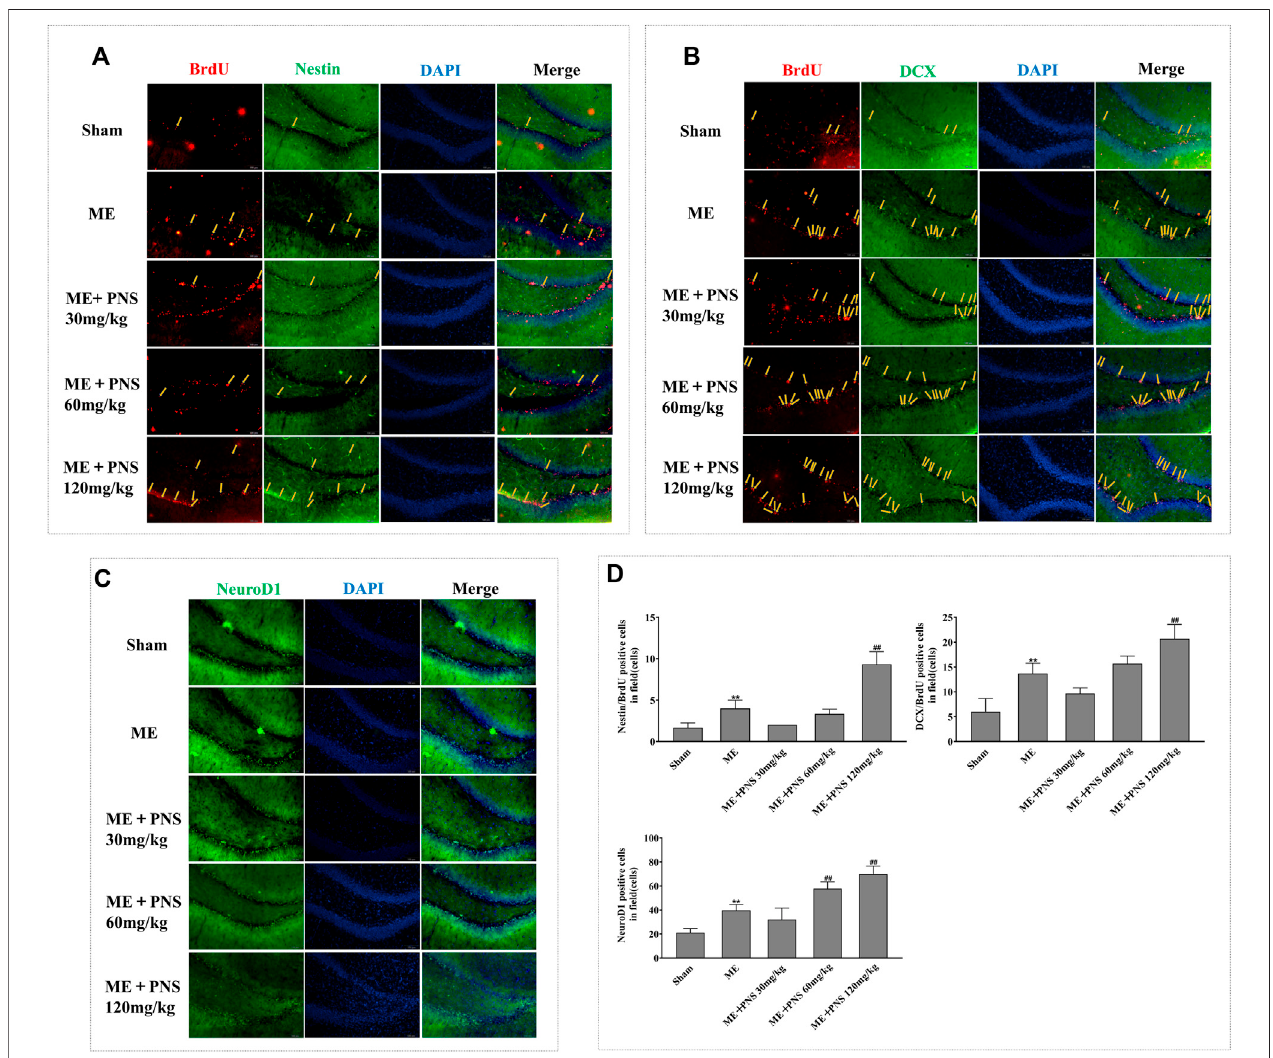
FIGURE 5 | PNS administration stimulated post-ischemic hippocampal neurogenesis in ME rats. Representative images of ipsilateral hemisphere sctions under a fl uorescence microscope at a magni fi cation of ×200 (scale bar =100 μ m) were shown as (A) BrdU (red, a marker of proliferating cells) and Nestin (green, a marker of NSC/NPC); (B) BrdU (red) and DCX (green, a marker of migrating neuroblasts); (C) NeuroD1 (green, a marker of differentiation factor). (D) The numbers of double- positiveofBrdU/Nestin,BrdU/DCX,andsingle-positiveNeuroD1wereanalyzedanddatawerepresentedasmeans±standarddeviation(n=3animalspergroup). * p < 0.05, ** p < 0.01 versus Sham group; # p < 0.05, ## p < 0.01 versus ME